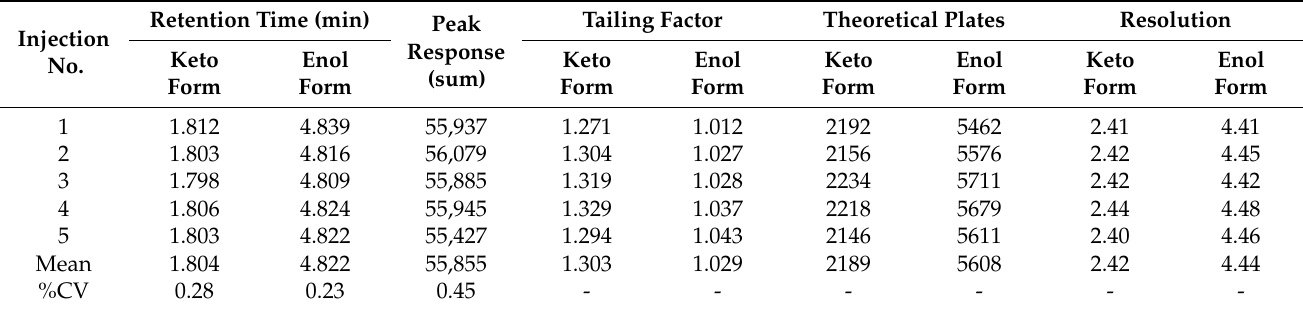
Table 1. System suitability parameters of TDG ( n = 5).